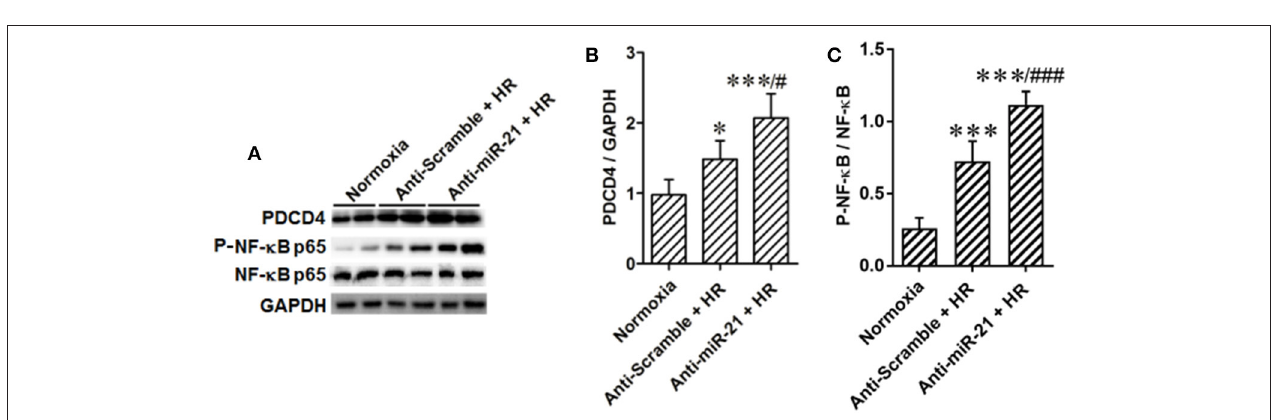
FIGURE 7 | Knockdown of miR-21 activates PDCD4/NF- κ B pathway in vitro. The effect of miR-21 on activation of PDCD4/NF- κ B pathway was assessed in HR cultured HK-2 cells. (A–C) Expressions of PDCD4 and NF- κ B were increased in the HK-2 cells challenged by HR and knockdown of miR-21 aggravated this effect. * P < 0.05, *** < 0.001, compared with Normoxia; # P < 0.051, ### P < 0.001, compared with Anti-scramble + HR, n =